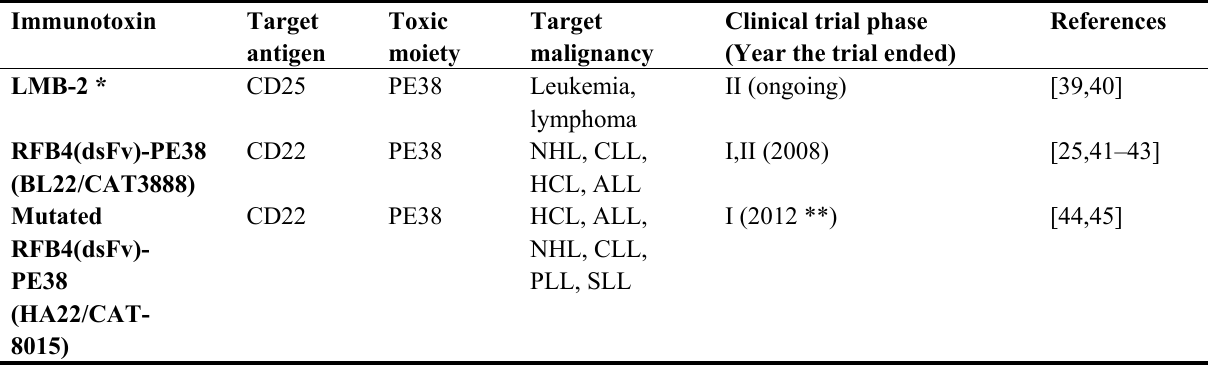
Table 1. Clinically evaluated/under evaluation PE-based immunotoxins against hematologic malignancies.